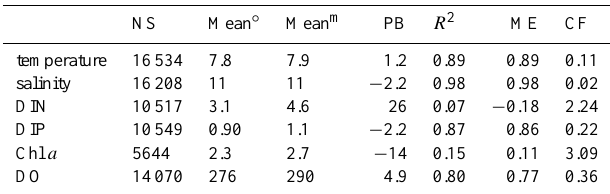
Table 3. Statistical measures of model-observation comparison overall. Abbreviations same as in Table